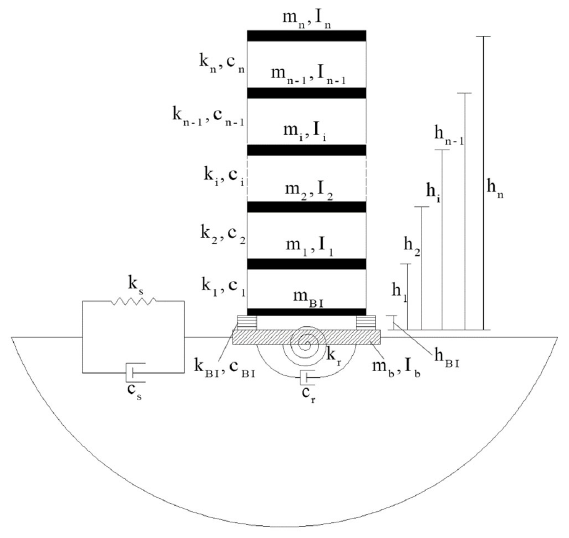
Figure 4. Shear building considering SSI and base isolation together.